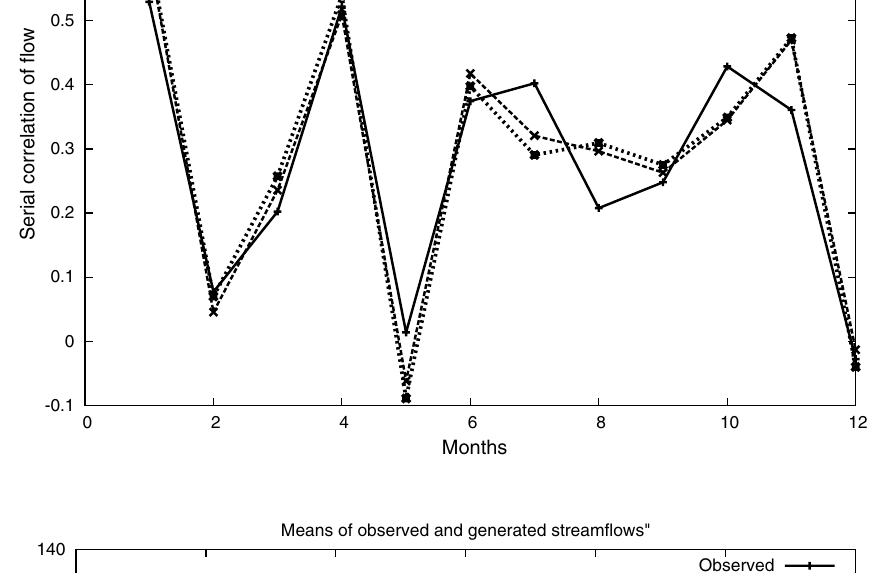
Fig. 6 Historical and gener- ated monthly means of flows in Barakar River (single-site